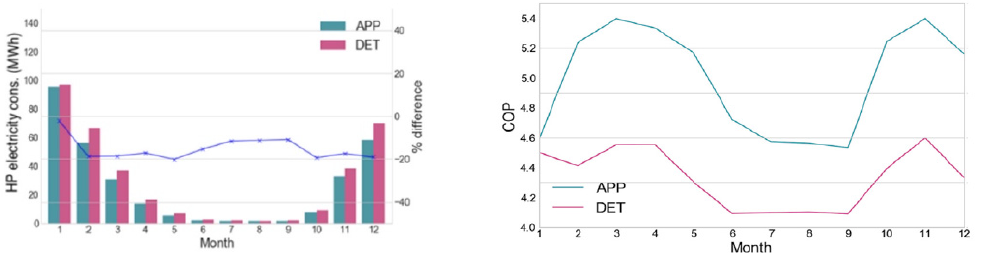
Figure 4. Electric consumption ( left ) and coefficient of performance ( right ) of HPs [177].